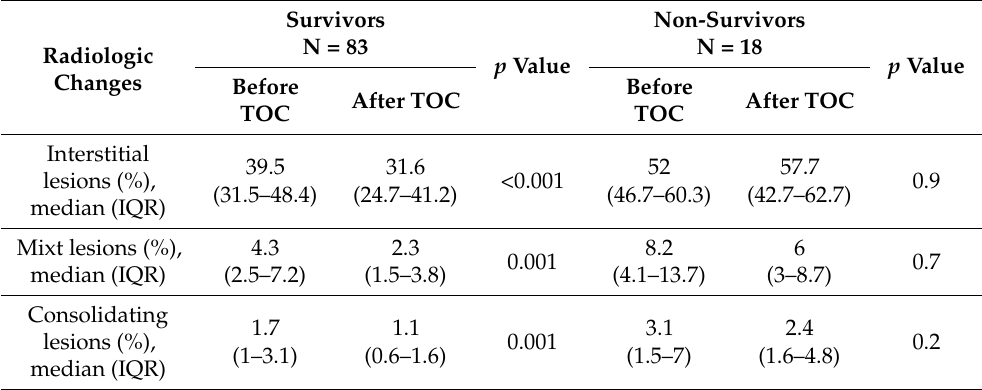
Table 2. Radiologic changes at 7–10 days after TOC administration, according to the